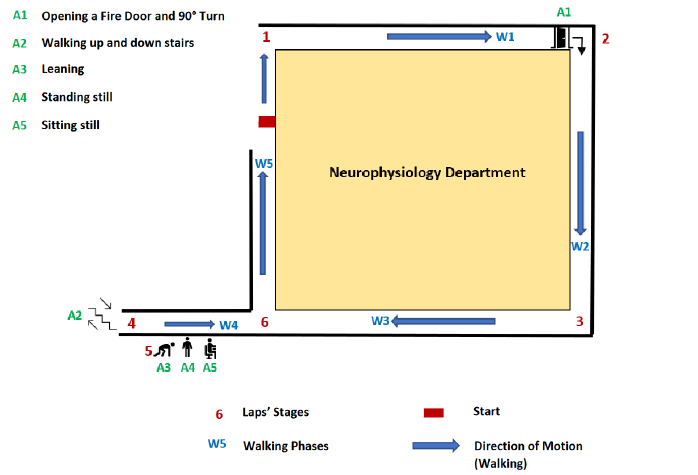
Figure 2. Description of the semi-controlled protocol. Numbers displayed indicate the position of the subject during its